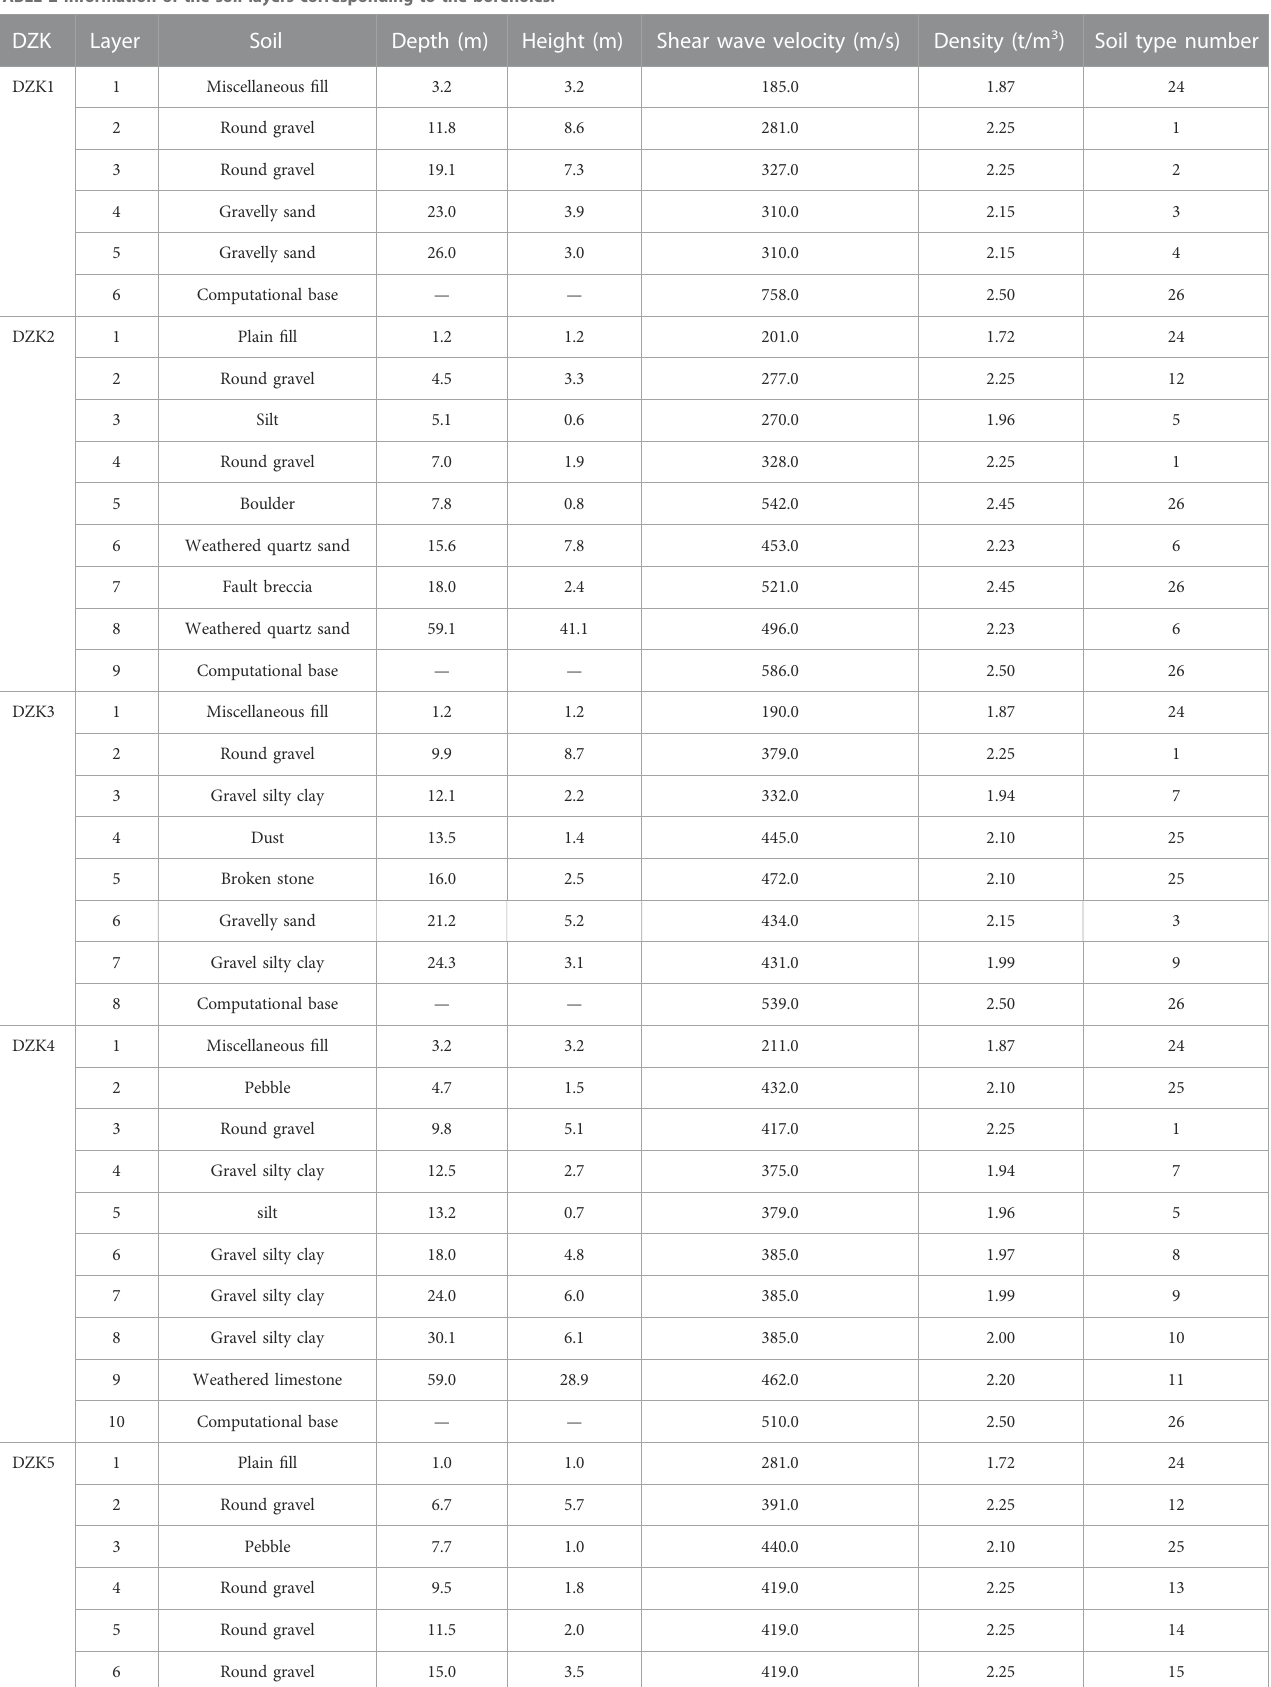
TABLE 2 Information of the soil layers corresponding to the